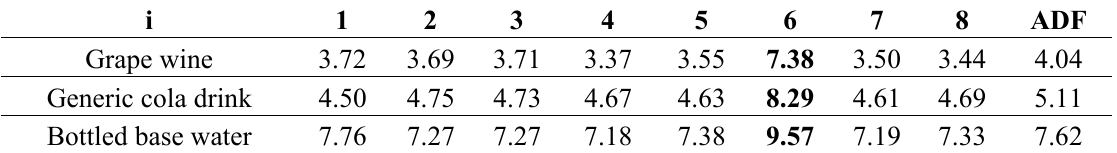
Table 2. The pH measured data of grape wine, generic cola drink and bottled base water drinks with sensor array and used average data fusion (ADF) to obtain fusion results.